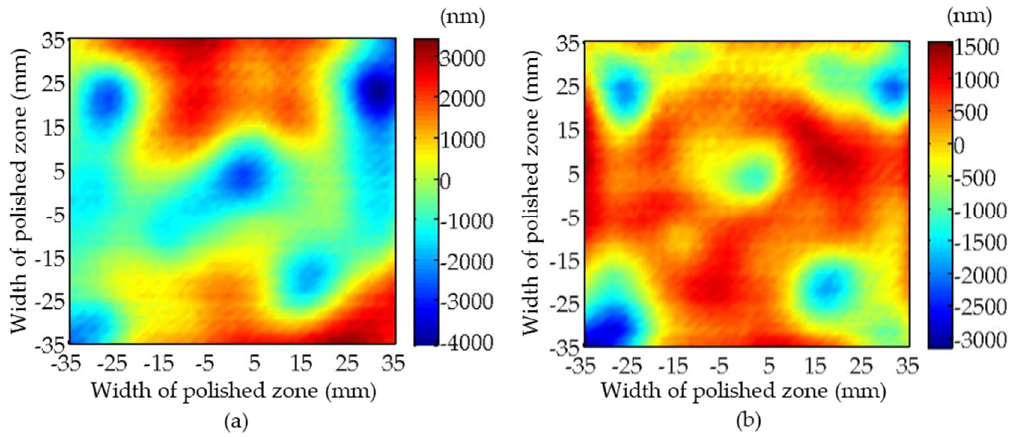
Figure 9. Changes in surface errors ( a ) before and ( b ) after conducting the linear interpolation-based polishing.